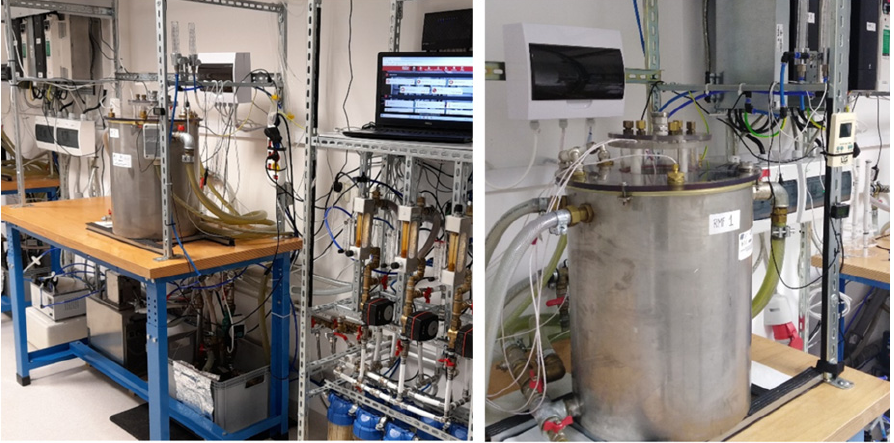
Figure 4. RMF generator with monitoring and control